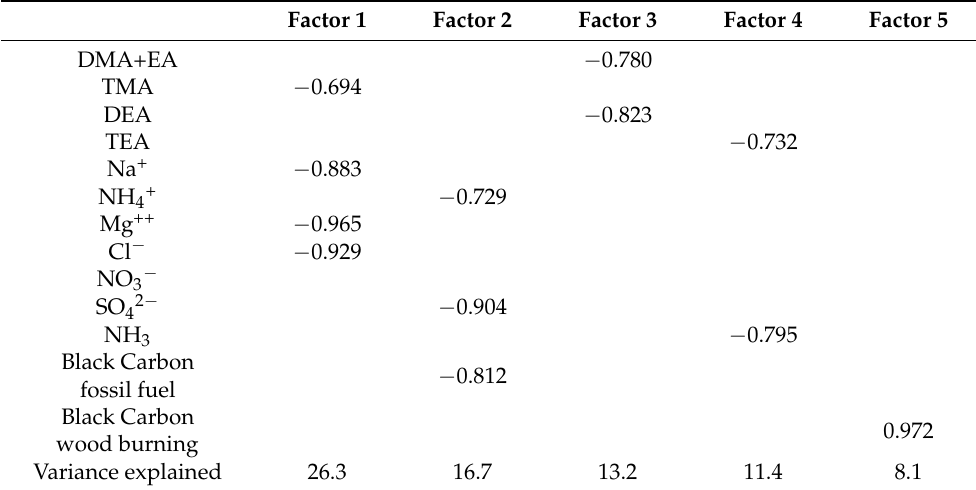
Table 3. Varimax-rotated factor matrix (correlations between variables and factors) and corresponding probable source type for alkylamines.